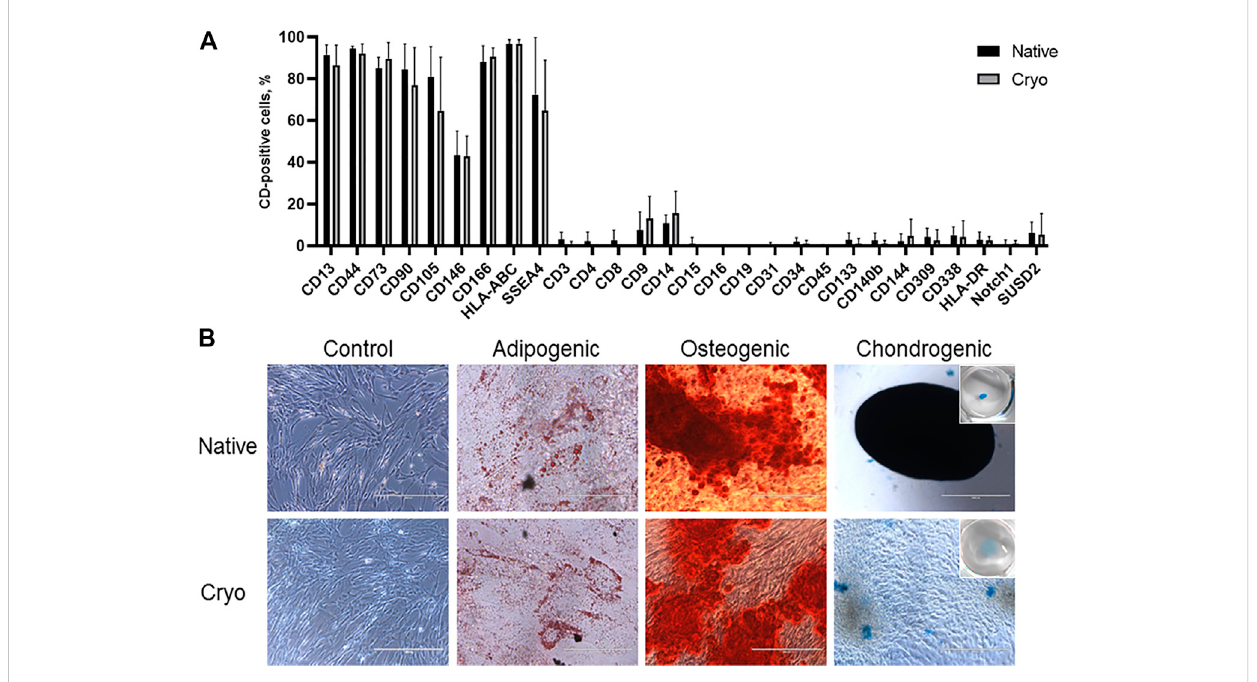
FIGURE 2 EvaluationofsurfacemarkersanddifferentiationpotencyofnativeandcryohPMSCs. (A) Cellsurfacemarkeranalysisofplacenta-derivednativeand cryo stromal cells. Characterization of native and cryo cells was performed using CD13, CD44, CD73, CD90, CD105, CD146, CD166, HLA-ABC, SSEA4, CD3, CD4, CD8, CD9, CD14, CD15, CD16, CD19, CD31, CD34, CD45, CD133, CD140b, CD144, CD309, CD338, HLA-DR, Notch1, and SUSD2 markers. Analysis was performed using fl ow cytometry. Results are presented as mean ± S.D. ( n = 6). (B) In vitro differentiation potential of native and cryo cells. Cells were differentiated into adipogenic (stained with Oil Red O), osteogenic (stained with Alizarin Red S), and chondrogenic (stained with Alcian Blue)lineages;representativeimages(scalebar=400 μ m,adipogenicdifferentiation=100 μ m,chondrogenicdifferentiationofnativecells=1,000